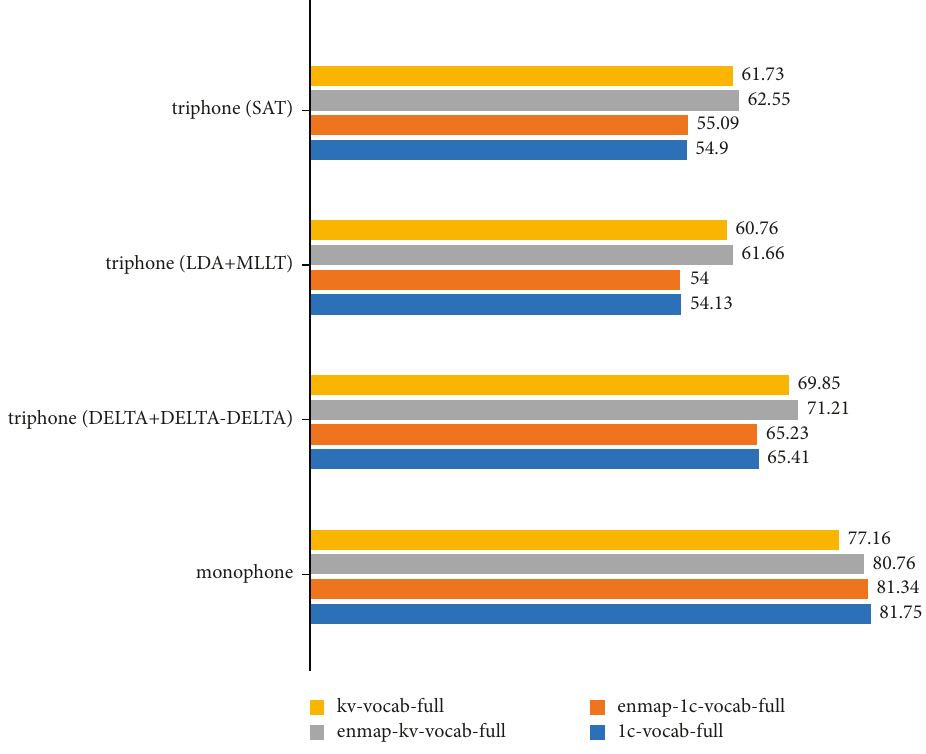
Figure 8: The %WER of the GMM-HMM models trained using 30,000 validated utterances.